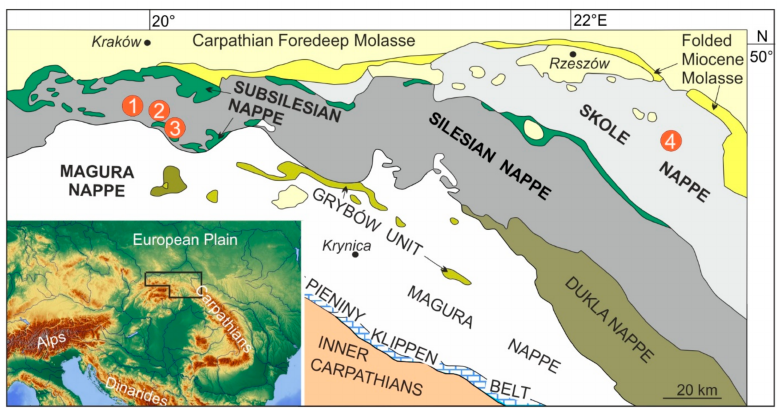
Figure 1. Position of the studied Cenomanian–Turonian boundary interval sections in the Outer Carpathians, Poland, in relation to the main geological units (geological units after [27]; 1— Barnasi ó wka, 2—Trzeme´snia, 3—Zasa´n, 4—Spława). Their accumulation rate was low, 3.5–5.5 mm/ka [3]. Accumulation of oxidized (red) non-calcareous hemipelagic clays began after the termination of the OAE2 throughout the entire Carpathian Basin. Its duration varied in particular basins, depending on the influx of terrigenous turbidites (summary in